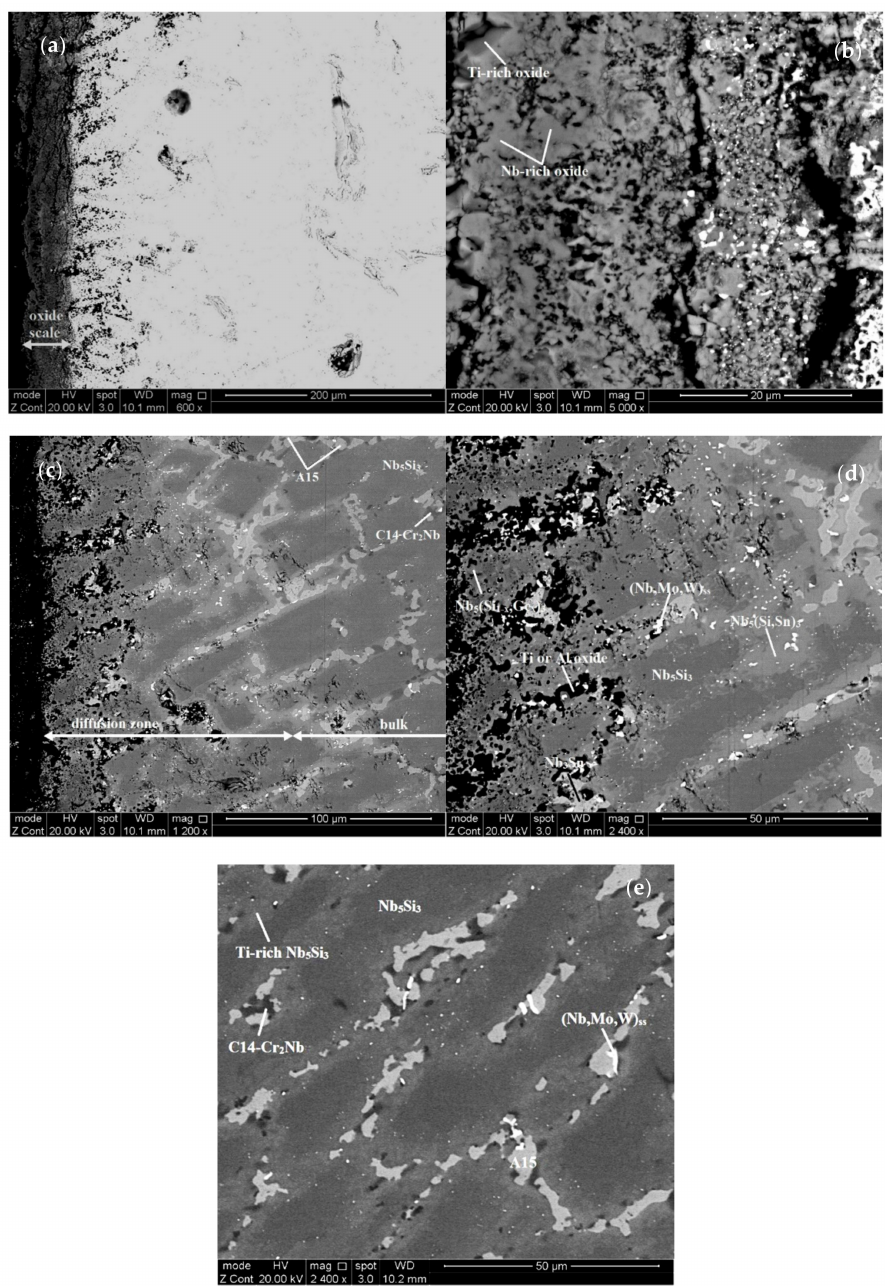
Figure 6. BSE images of the microstructure of a cross section of the oxidised alloy JZ5 at 1200 ◦ C, ( a ) oxide scale, di ff usion zone and bulk, ( b ) oxide scale, ( c ) di ff usion zone and bulk, ( d ) microstructure of the di ff usion zone and ( e ) bulk